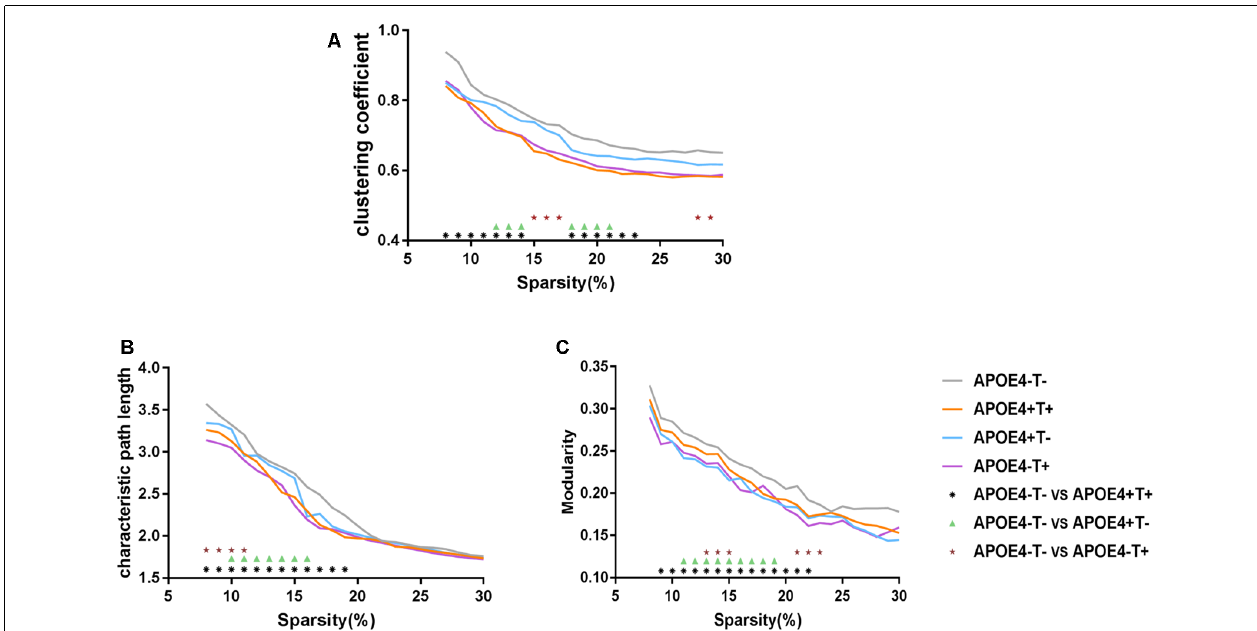
FIGURE 3 | Network properties. Mean values for the clustering coefficient (A) , characteristic path length (B) and modularity (C) for APOE 4 − T − (gray), APOE 4+T+ (orange), APOE 4+T − (blue), APOE 4 − T+ (purple) at different network densities. Black asterisk indicates a statistically significant difference between APOE 4 − T − and APOE 4+T+. Green triangle indicates a statistically significant difference between APOE 4 − T − and APOE 4+T − . Brown star indicates a statistically significant difference between APOE 4 − T − and APOE 4 − T+.